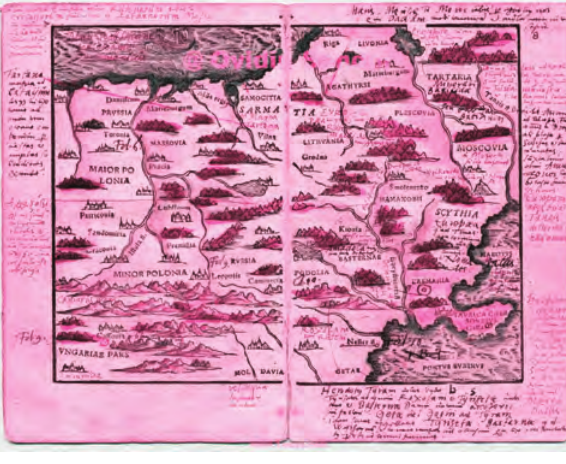
Fig. 6. Map of Sarmatija of Johan Honter (1530, 1542,